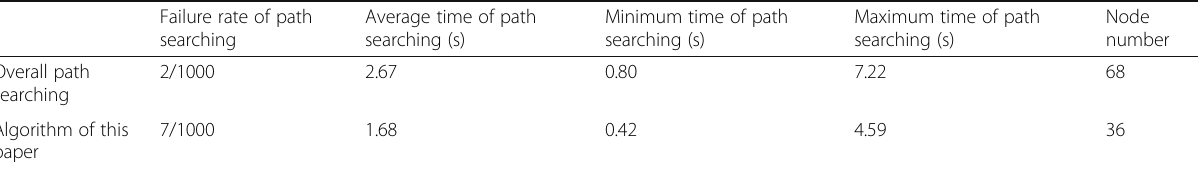
Table 2 Performance of different path searching algorithm Failure rate of path Average time of path searching searching (s)